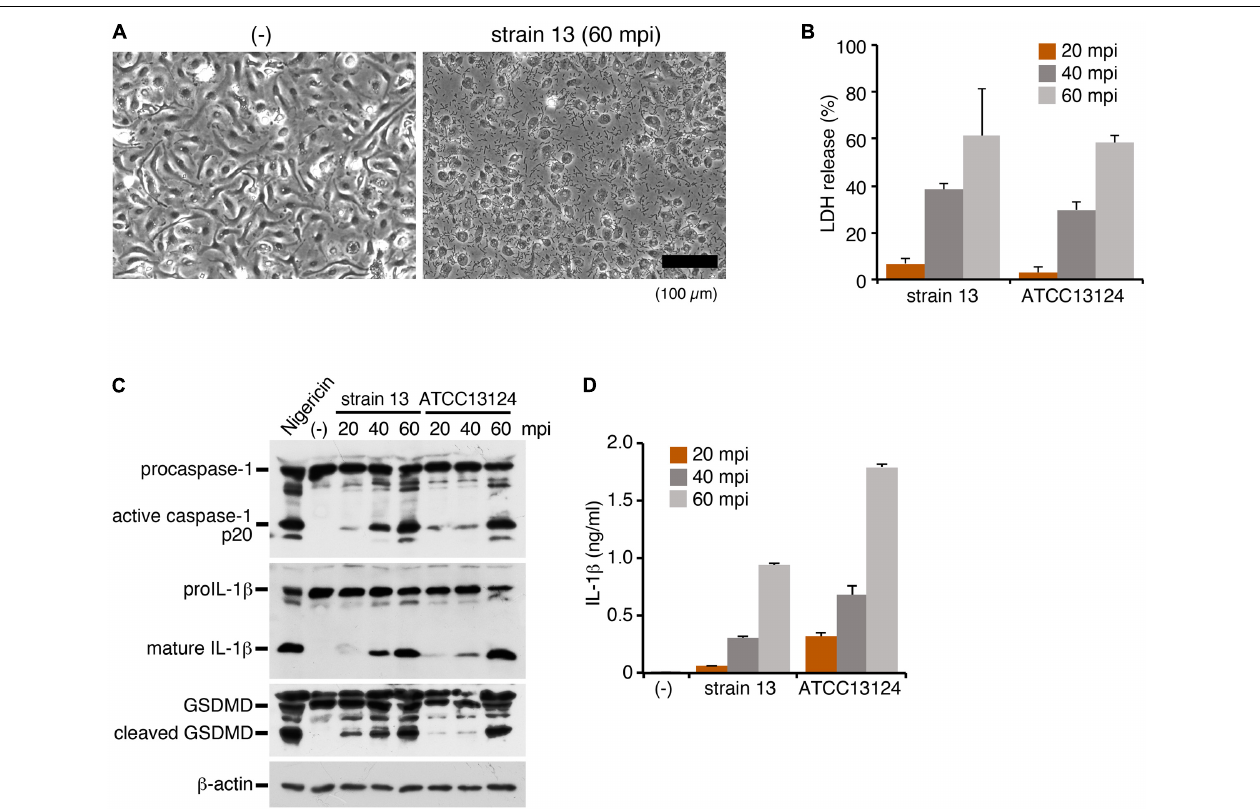
FIGURE 1 | Infection with Clostridium perfringens induces inflammasome activation with caspase-1 activation, IL-1 β release and pyroptosis in macrophages. BMDMs from C57BL/6 mice were primed with LPS (100 ng/ml) for 2 h and infected with C. perfringens (strain 13 or ATCC13124) for the indicated times, or treated with 10 µ M nigericin for 30 min as a positive control. (A) Phase- contrast images of uninfected (-) or strain 13-infected BMDMs at 60 mpi. Bar, 100 µ m. (B) Culture supernatants of the infected BMDMs were analyzed for LDH release at 20–60 mpi. (C) Activation of caspase-1, and cleavage of IL-1 β or GSDMD in the infected BMDMs was analyzed by immunoblotting with anti-caspase-1 (p20), anti-IL-1 β and anti-GSDMD antibody, respectively. The levels of β -actin as the loading control were also examined. (D) IL-1 β release from the infected BMDMs into the culture supernatants at 20–60 mpi was analyzed by an ELISA. Data are presented as the means ± SD of triplicate